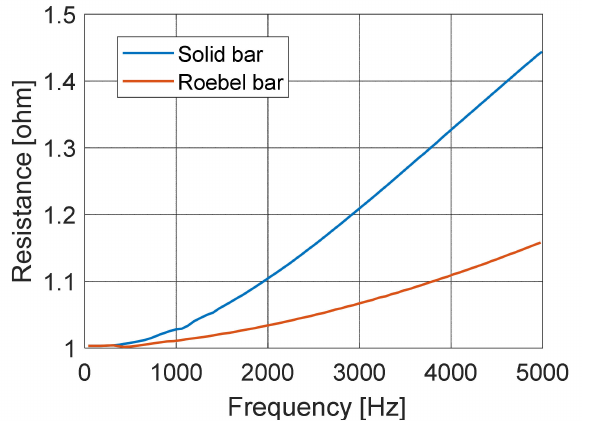
Figure 19. Comparison between the resistance of AM twisted Roebel bar and solid bar at different frequency levels